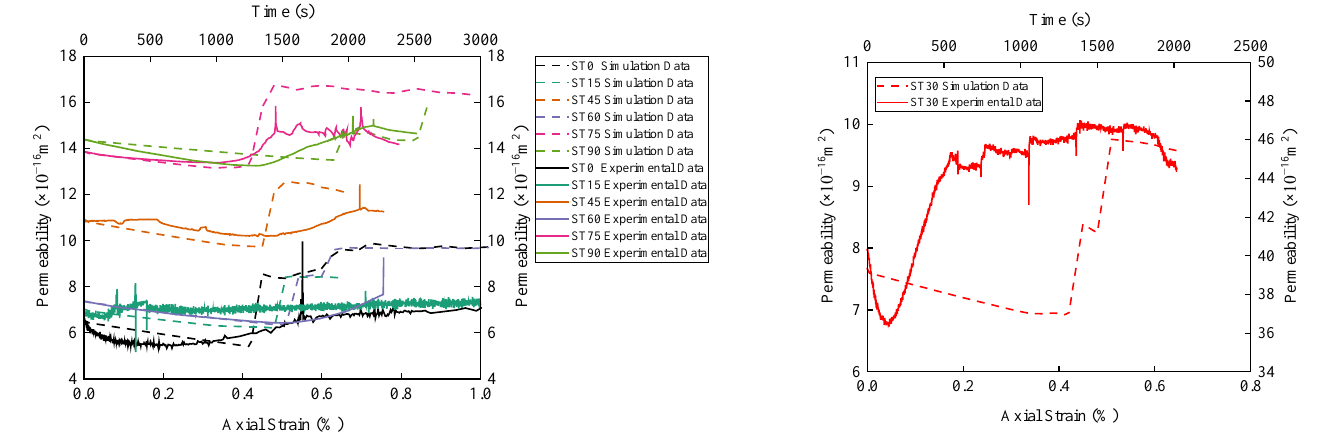
Figure 12. Simulation results of T - shaped fracture sandstone specimens under the action of hy- dro - mechanical coupling. ( a ) Progressive failure process of ST0 specimen, ( b ) Failure modes of ST15 - ST90 specimens .